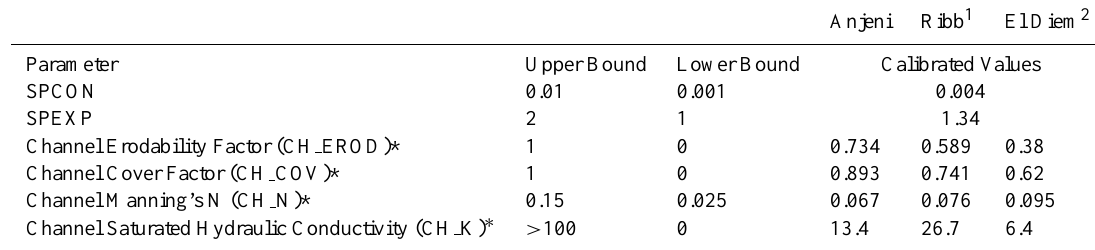
Table 3. Parameters affecting channel degradation and deposition of sediment calibrated using leave one out cross validation for Anjeni, Ribb, and El